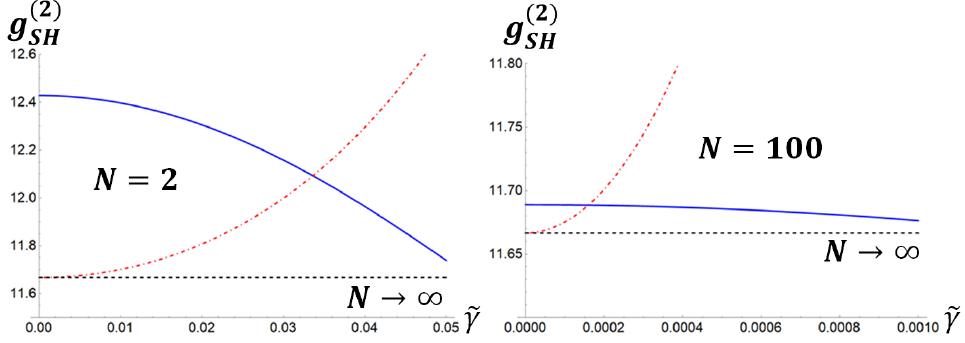
Figure 4. Squeezed input state. Solid blue line: SH autocorrelation function, from Equation (56). Dashed line: SH autocorrelation function in the absence of annihilation processes and